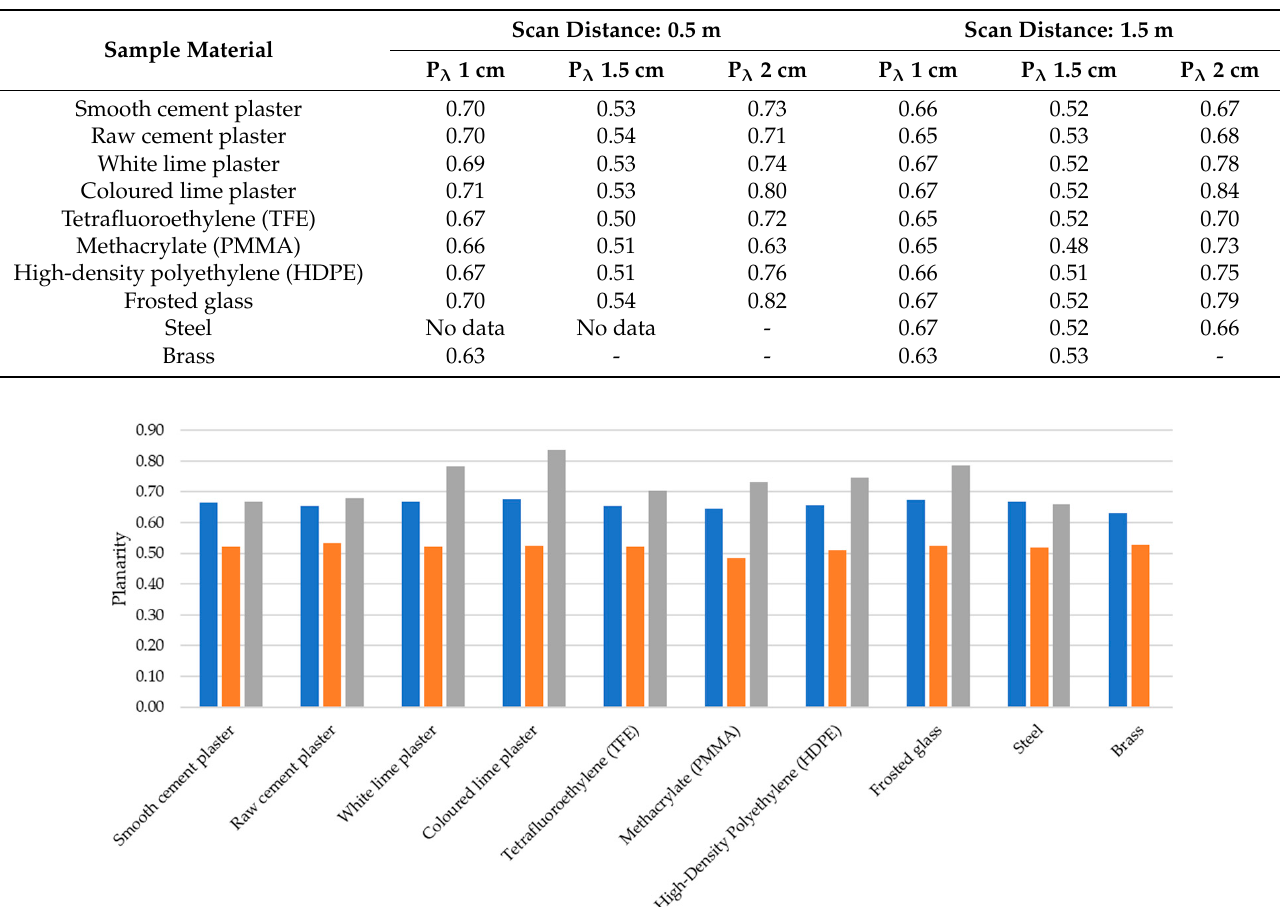
Table A2. Mean Planarity values of the scans of the 10 samples.